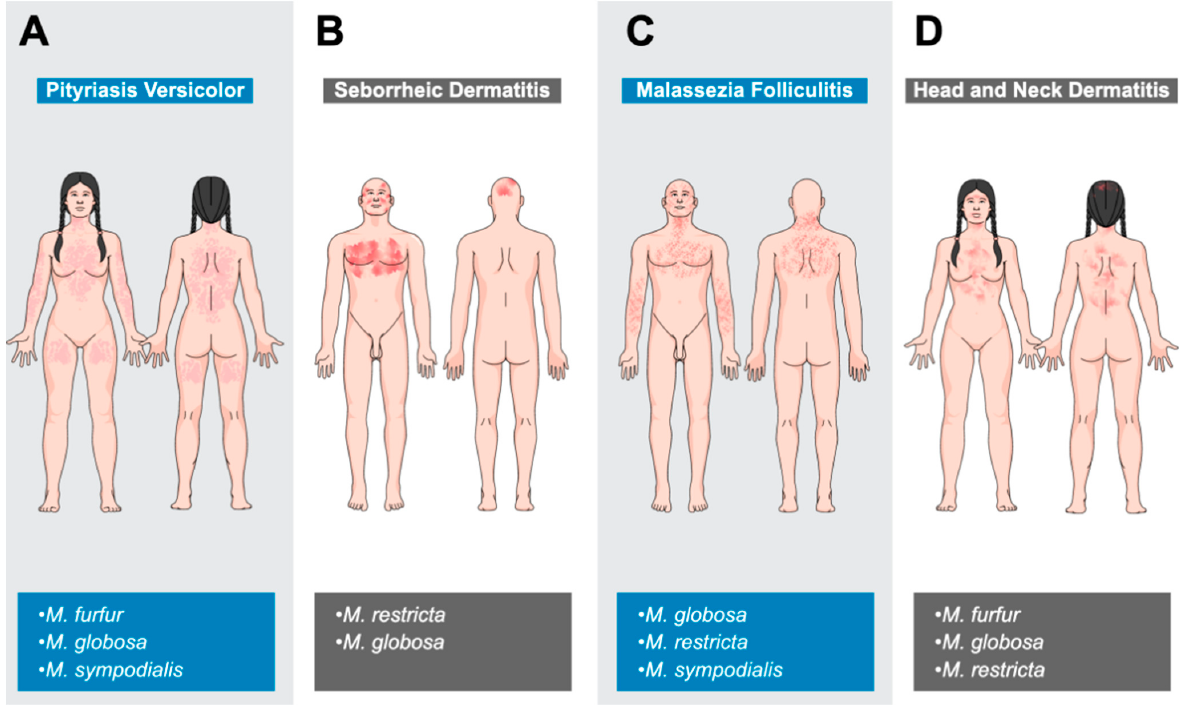
Figure 3. Overview of Malassezia -associated skin diseases in humans. Typical affected areas for pit- yriasis versicolor ( A ), seborrheic dermatitis ( B ), Malassezia- associated folliculitis ( C ) and head and neck dermatitis ( D) , as well as commonly involved Malassezia species, are shown.